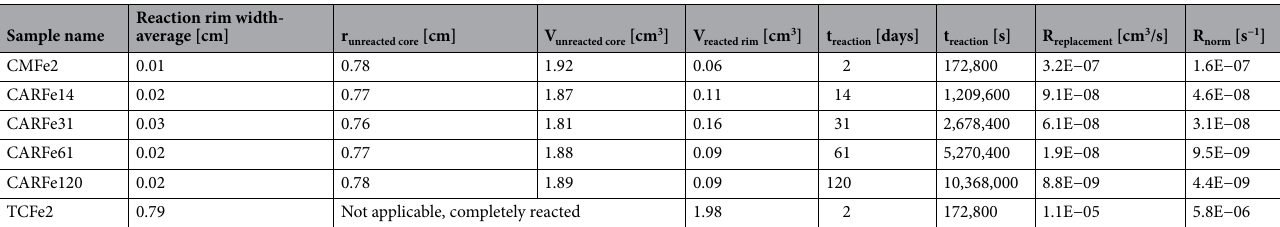
Table 1. Replacement rate based on SEM-BSE image analysis. V core = 1.98 cm 3